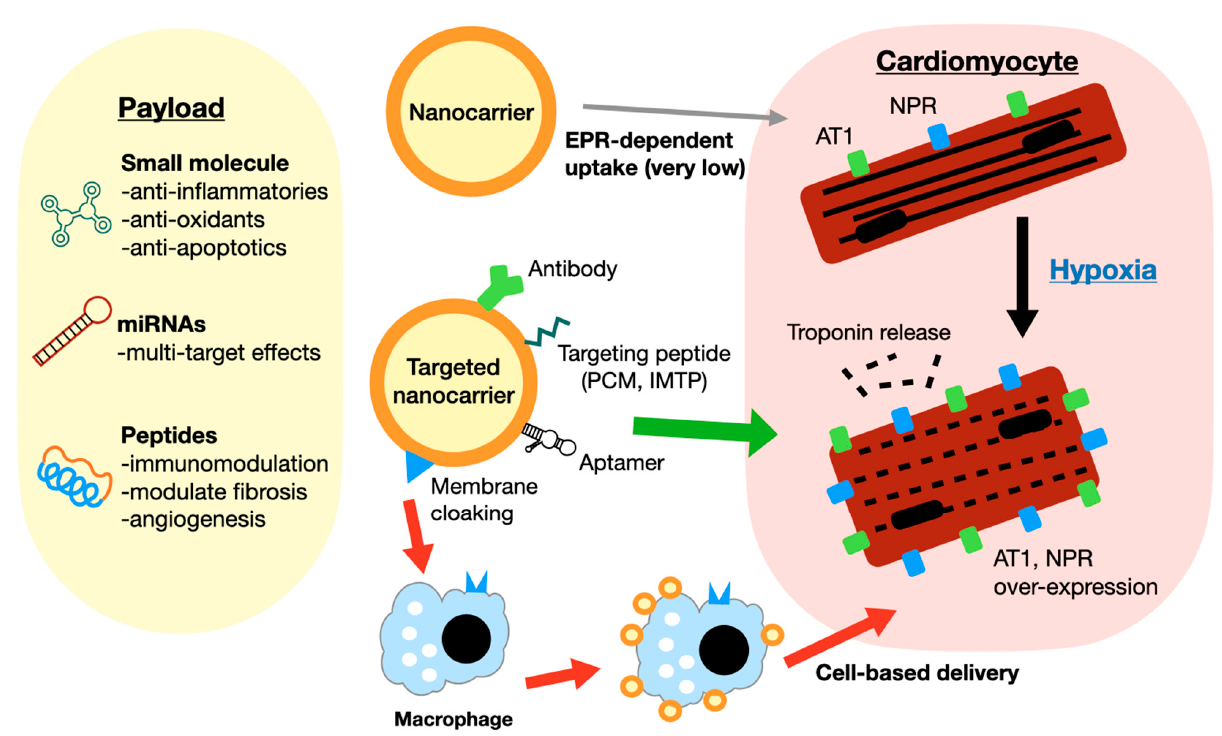
Figure 2. A summary of selected promising nanocarrier drug delivery strategies is shown. Nanocar- riers carry payloads of single or multiple small molecules, miRNAs, or peptides with diverse